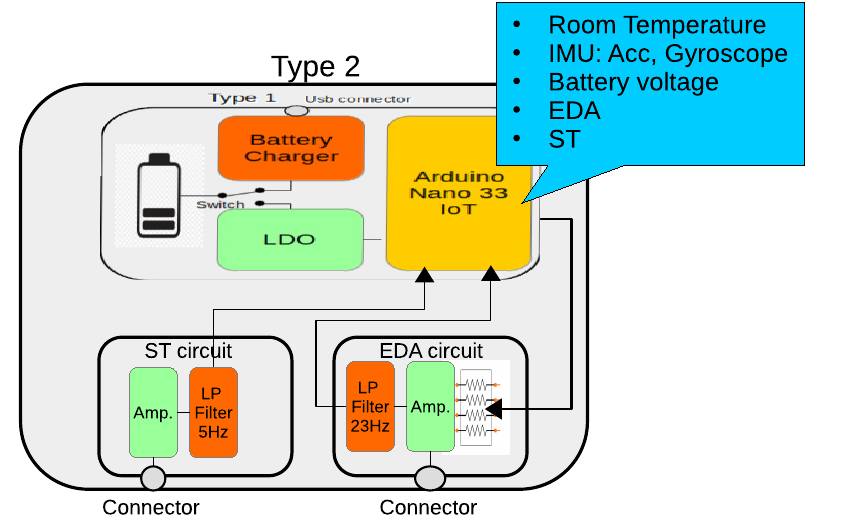
Figure 4. Block diagram of the the Type 2 wearable. It contains an EDA circuit with a programmable gain amplifier to adapt to different skin resistances and a low-pass filter. The ST circuit is made of an input amplifier and an output low-pass